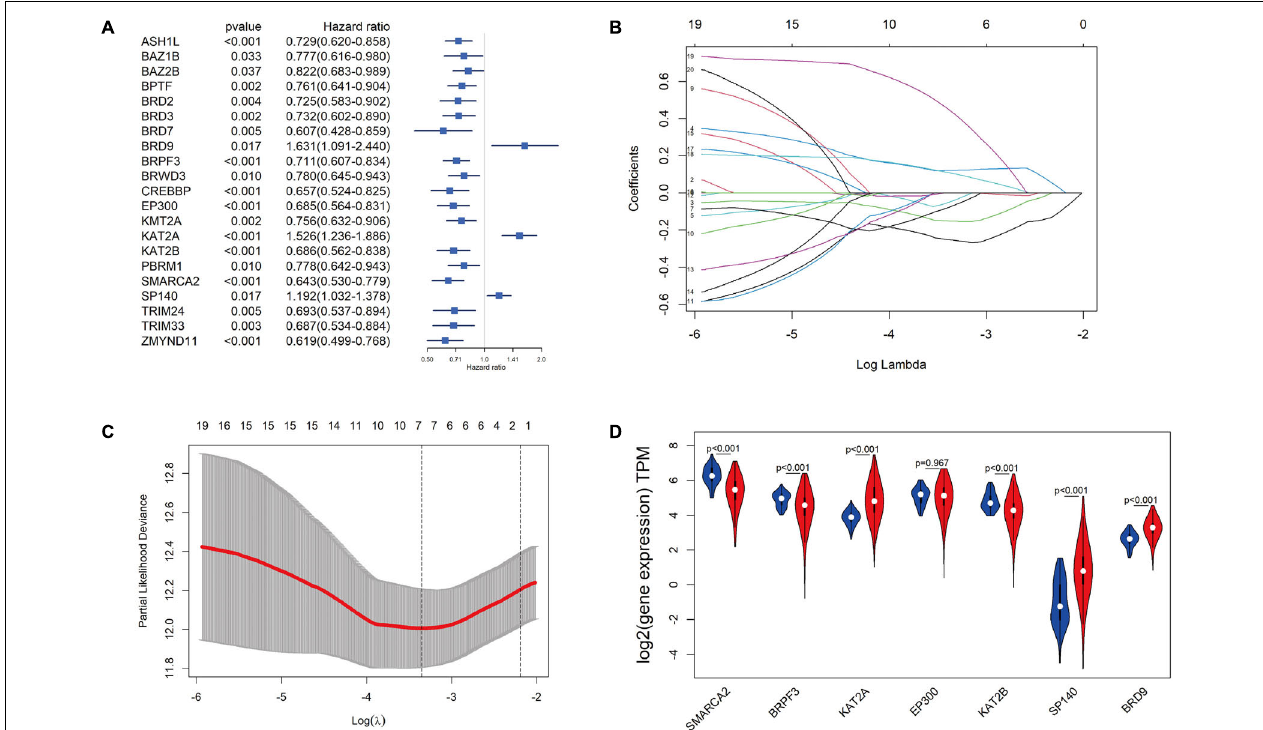
FIGURE 4 | Construction of the BRD gene prognostic risk signature. (A) Univariate Cox regression of BRD genes with P-values < 0.05. (B) The LASSO coefficient profile of the remaining 21 BRD genes after analysis with univariate Cox regression. (C) The partial likelihood deviance is shown against log (lambda) with the vertical line drawn according to the selected values using 10-fold cross-validation. (D) Differentially expressed analysis of seven model BRD genes. The normal control is presented in blue, and KIRC samples are presented in red.